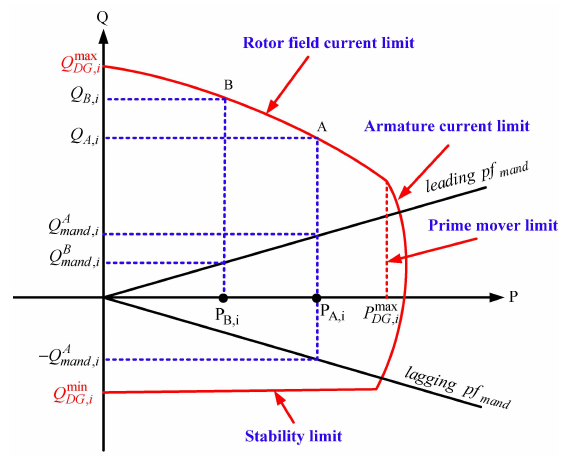
Figure 1. Capability diagram of a synchronous